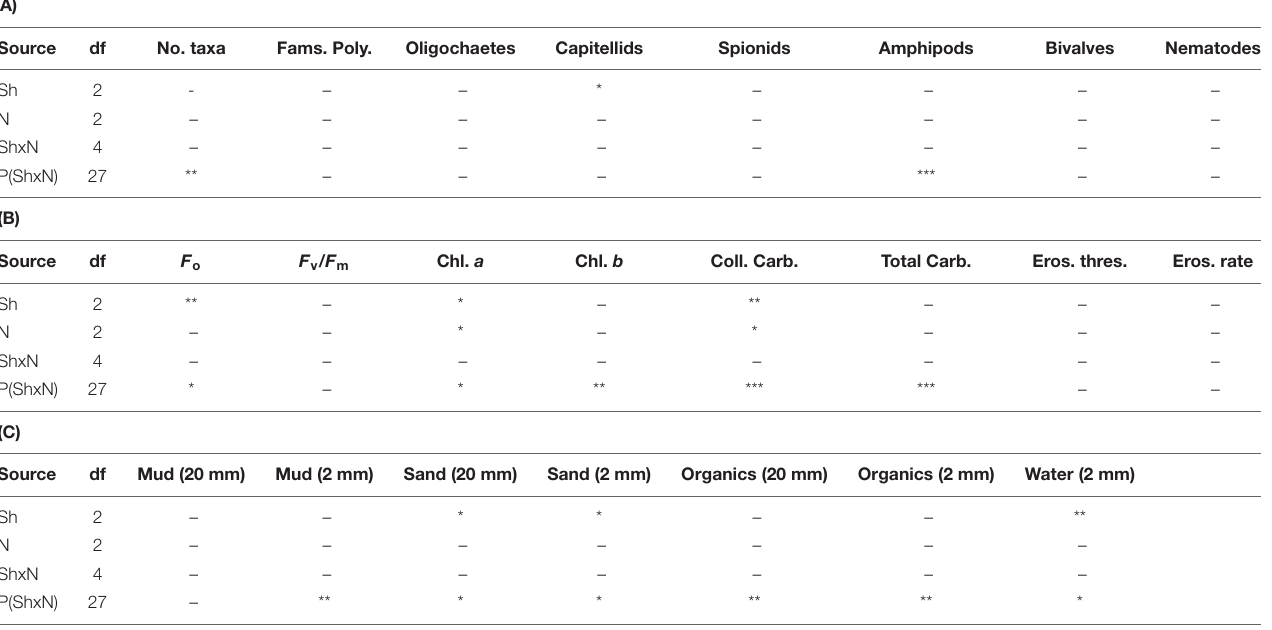
TABLE 1 | ANOVA for macrofauna and properties of sediments in plots subjected to Shading (Sh), addition of Nutrients (N) and appropriate control treatments, experiment 1 at Tambourine Bay after 2 weeks; details in text. 20 mm is data from syringe core, 2 mm is data from contact core, 2 samples from each of n = 4 replicate